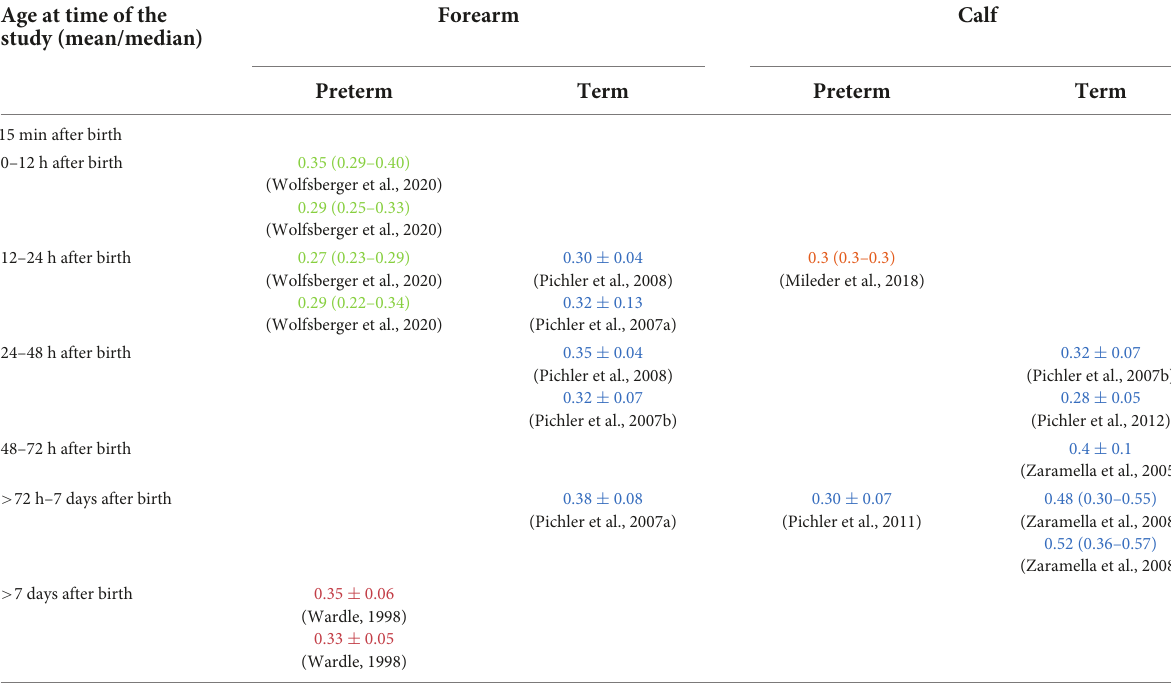
TABLE 3 pFOE in stable preterm and term neonates sorted according to the time point of measurement after birth. Age at time of the Forearm study (mean/median)